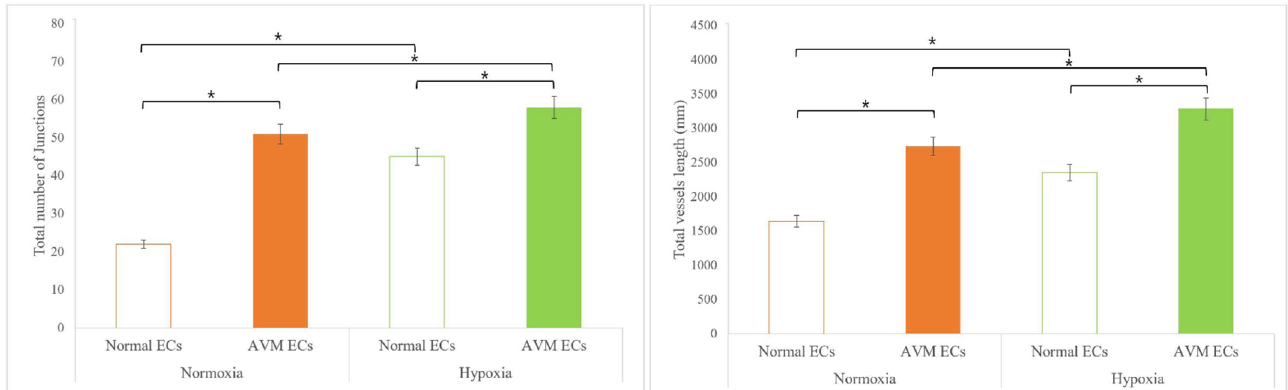
Figure 4. Total number of junctions and total vessel length of normal ECs and AVM ECs in normoxia and hypoxia. Compared with that of normal ECs, AVM ECs showed significantly increased total numbers of junctions and total vessel lengths. More and longer tubes were formed in AVM ECs than normal ECs even in the hypoxia. * p < 0.05. AVM, arteriovenous malformation; EC, endothelial cell.